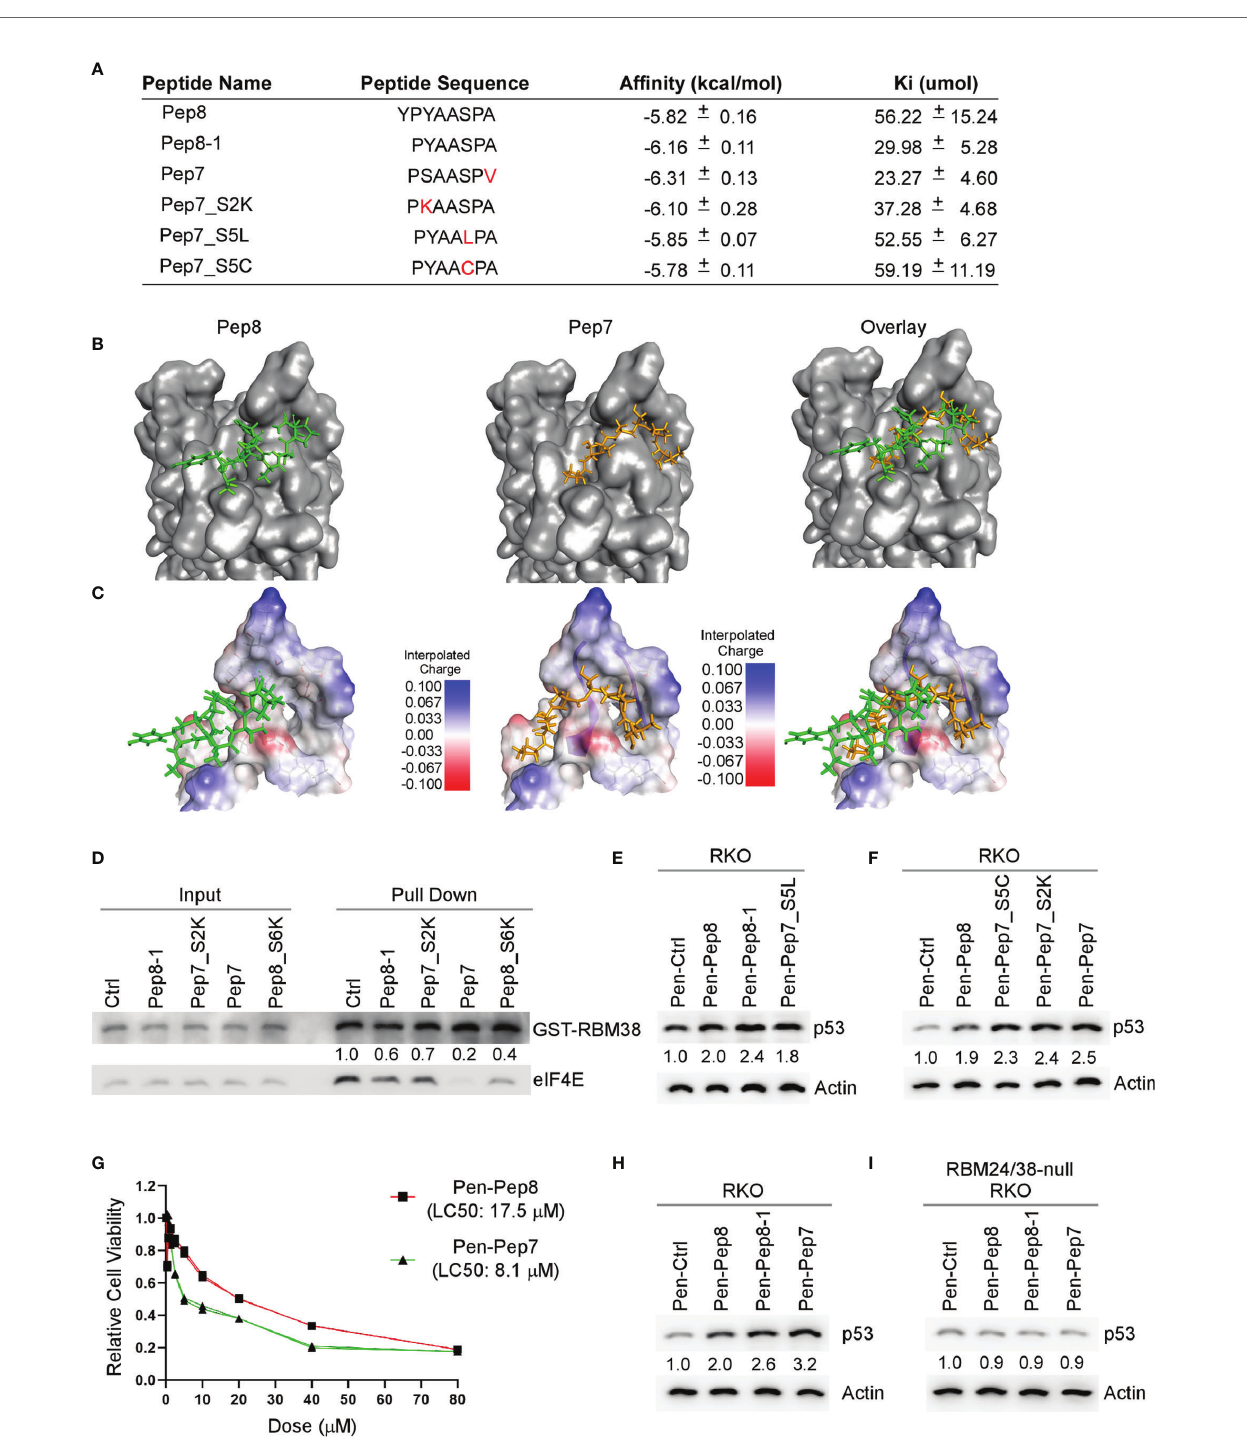
FIGURE 2 | Bioactivity optimization of Pep8 peptide. (A) List of peptide names and sequences, as well as the calculated binding af fi nity and equilibrium dissociation constant (Ki) for each peptide as determined by AutoDock Vina. (B) Visualization of the binding mode for Pep8 and Pep7. (C) Visualization of the interpolated charge surface of eIF4E and the corresponding peptide. (D) Immunoblot for the competitive pull-down assay for GST-RBM38 and eIF4E with the addition of Pep8 derivatives. (E, F) The levels of p53 and actin proteins were measured in RKO cells treated with 20 µM Penetratin fused peptides for 18 hrs. (G) RKO colon cancer cells were exposed (in triplicates) to a wide range of concentrations of either Pen-Pep8 or Pen-Pep7 (0.3125 – 80 µM) and the lethal concentration for 50% cell death (LC50) was calculated based on a sigmoidal effect (% cell death) model. (H, I) The levels of p53 and actin proteins were measured in wild-type (H) and RBM24/RBM38 double knockout (I) RKO cells treated with 20 µM Penetratin fused peptides for 18